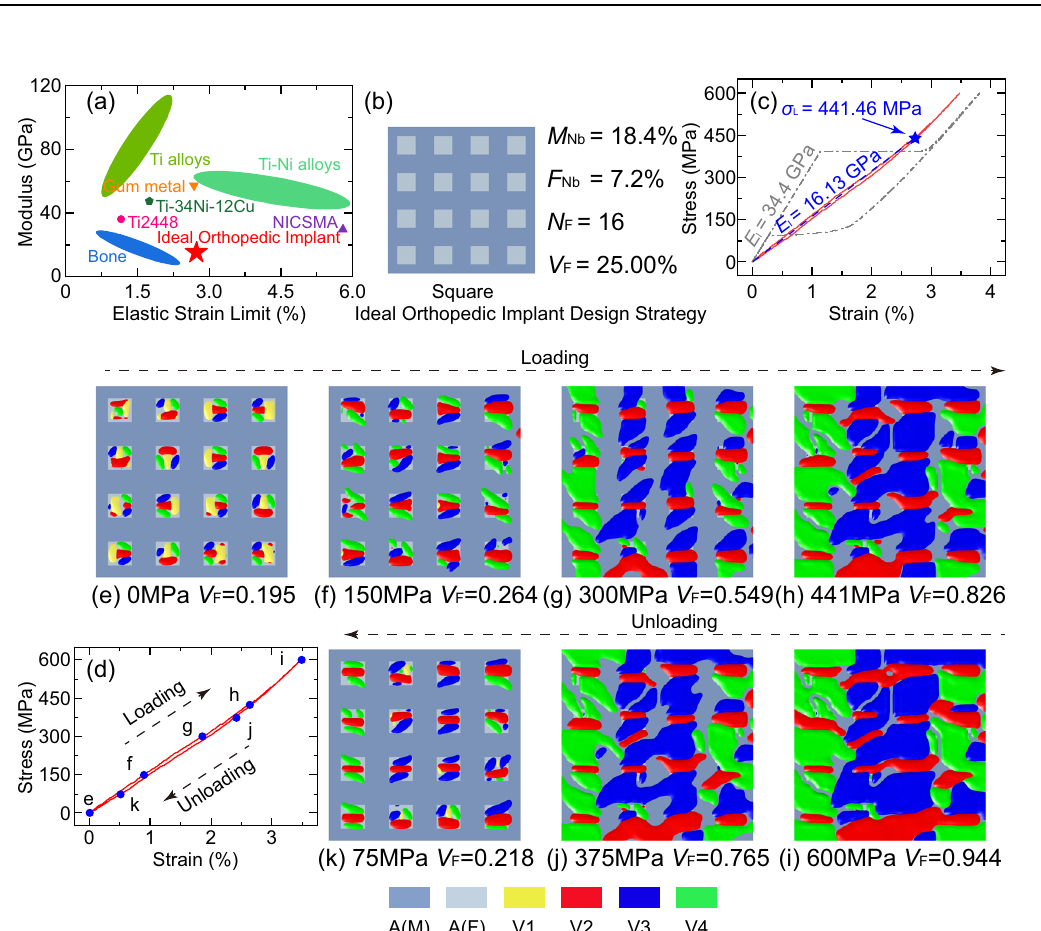
Fig. 5 Phase- fi eld simulation of SS curve and corresponding microsctructural evolution in ideal orthopedic implant. a Comparison of the modulus and elastic strain limit between prediction from this study with those reported in the literature. b The con fi guration of the ideal orthopedic implant obtained from the ML-guided HTP phase- fi eld simulations. c SS curves of ideal orthopedic implant (red curve) and Ti2448 (gray curve). d Microstructure evolution during MT in ideal orthopedic implant during loading e-h , and unloading i-k process. the red curve and gray curve, respectively. The SS curve of Ti2448